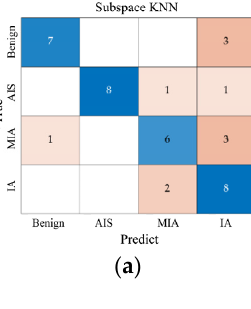
Figure 5. The confusion matrix and ROC curve for the classification of the four pathological subtypes. ( a , c ) FFDC; ( b , d ) OFDC.